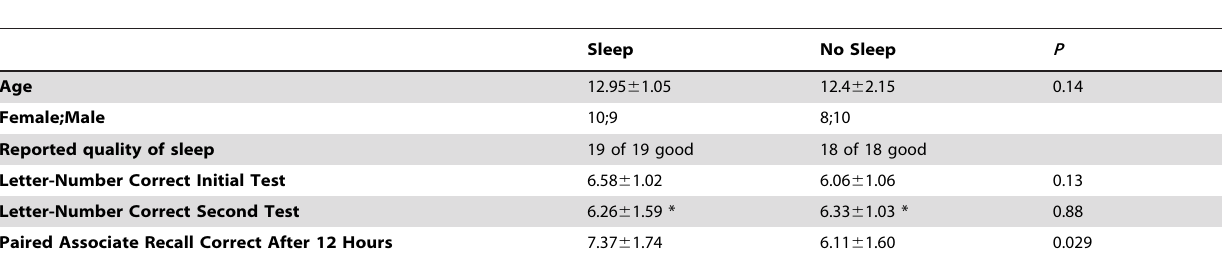
Table 1. Demographic and performance scores for subjects in the sleep (n=19) and no sleep (n=18) conditions with outliers removed.